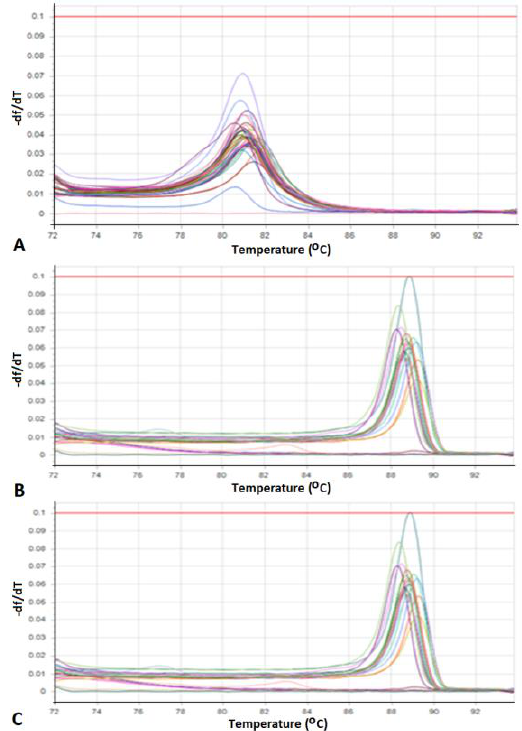
Fig. 1 . Melting curves of Real-time PCR: A) hsa- miR-490-5p ; B) NFAT ; C) RNU6 .